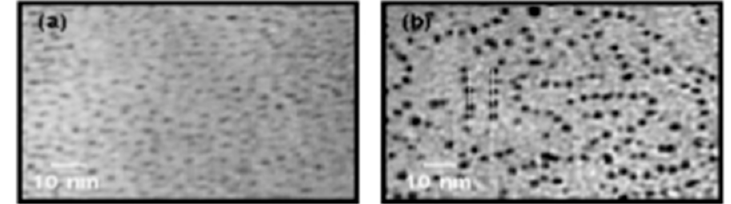
Figure 4. Transmission electron microscopy (TEM) images of Au nanoparticles with NLC ligands ( a ) before and ( b ) after thermal treatment. Reproduced with permission from Ref. [79]. (Royal Society of Chemistry).